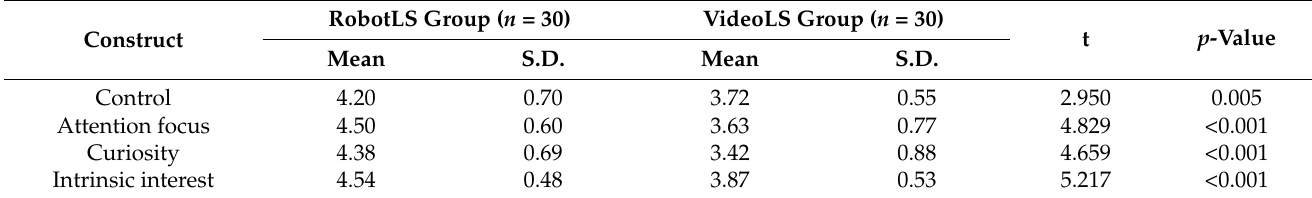
Table 7. Independent samples t-test on flow